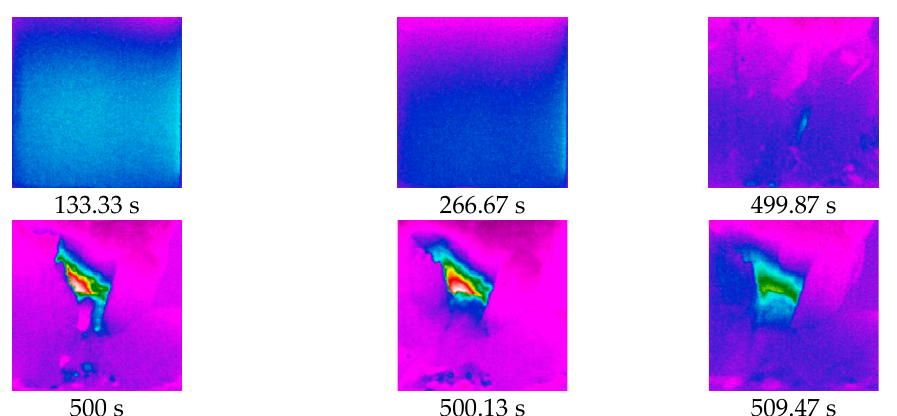
Figure 5. Cloud diagram of temperature field change during DL1-3 specimen failure.